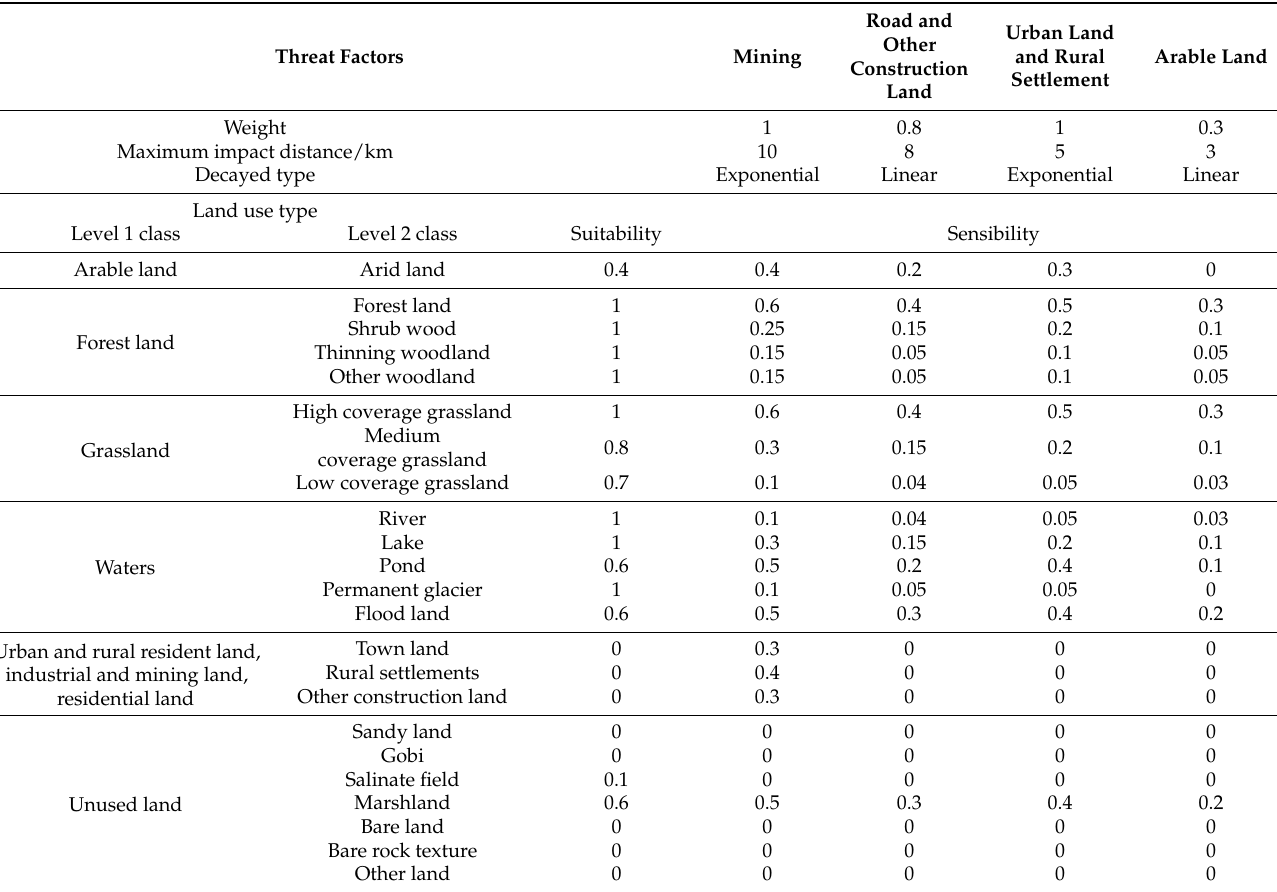
Table 2. Sensitivity of different land-use types to threat